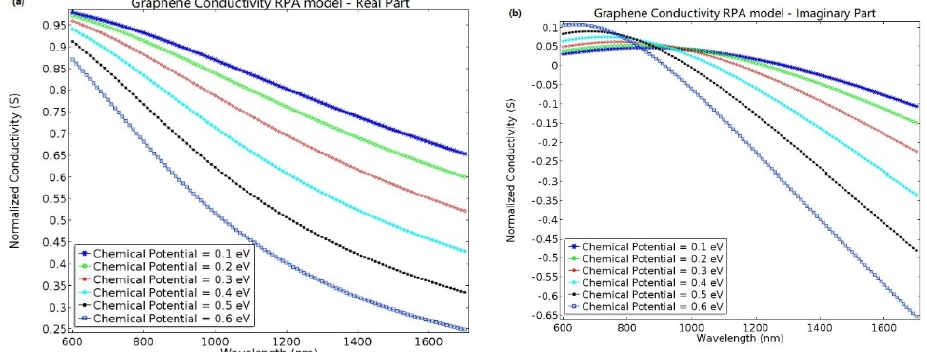
Figure 2. The normalized conductivity of graphene versus wavelength for different chemical potentials, calculated by random phase approximation (RPA) model. The blue asterisk, green circle, red diamond, cyan plus sign, black point, and blue square correspond to chemical potentials of 0.1, 0.2, 0.3, 0.4, 0.5, and 0.6 eV, respectively. ( a , b ) are the real part and imaginary part of graphene conductivity, respectively.